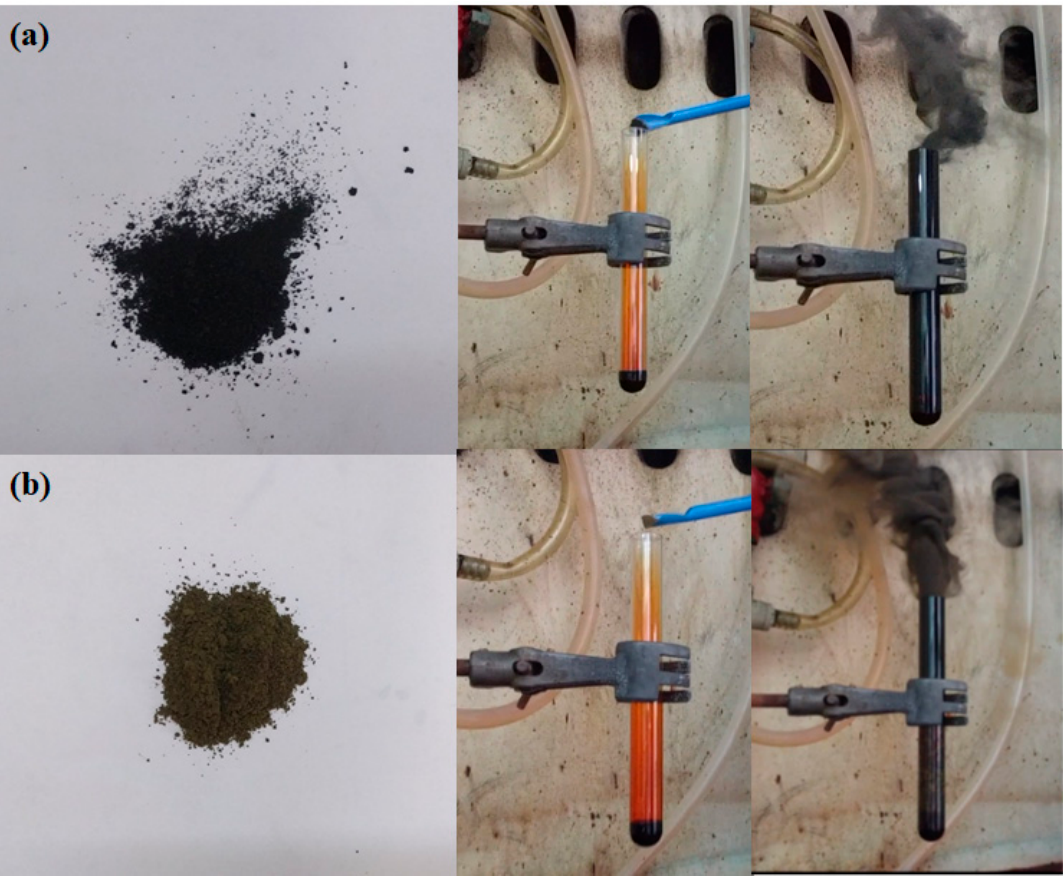
Figure 2. Cobaltocene ( a ) and nickelocene ( b ) reacted similarly to ferrocene upon liquid bromine to release carbon soot.